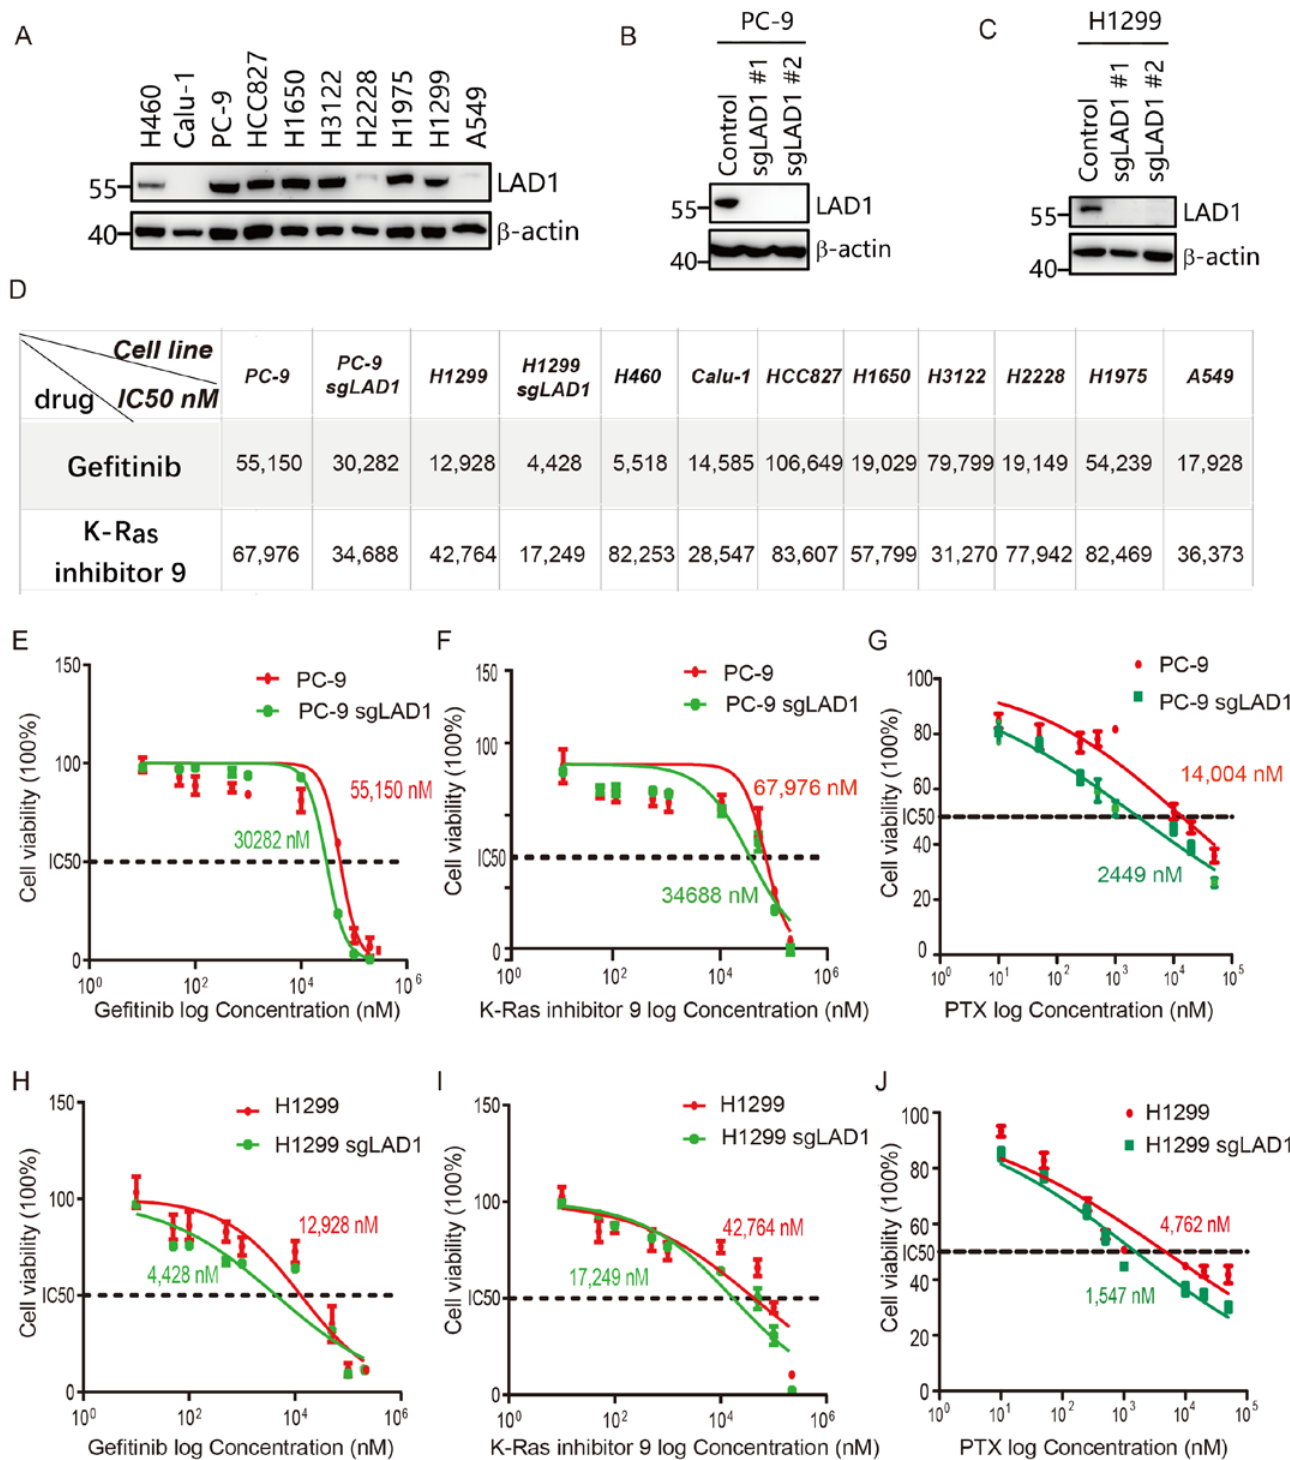
Figure 7. LAD1 contributes to drug resistance in LUAD cells. ( A ) Expression levels of LAD1 as detected by Western blot in LUSC, LCLC, and LUAD cell lines. β -actin was used as a loading control. ( B , C ) LAD1 knockout by two sgRNAs (sgLAD1 #1 and sgLAD1 #2) in PC-9 and H1299 was examined by Western blot. ( D ) A summary of the CCK8 assay was used to test the cell viability upon drug treatment. Each experiment was repeated three times. The IC50 values of control and LAD1-knockout PC-9 ( E – G ) and H1299 ( H – J ) cells were determined by CCK8 assay. Results were analyzed with GraphPad Prism 5. Error bars, means ± SD ( n = 3 independent experiments).